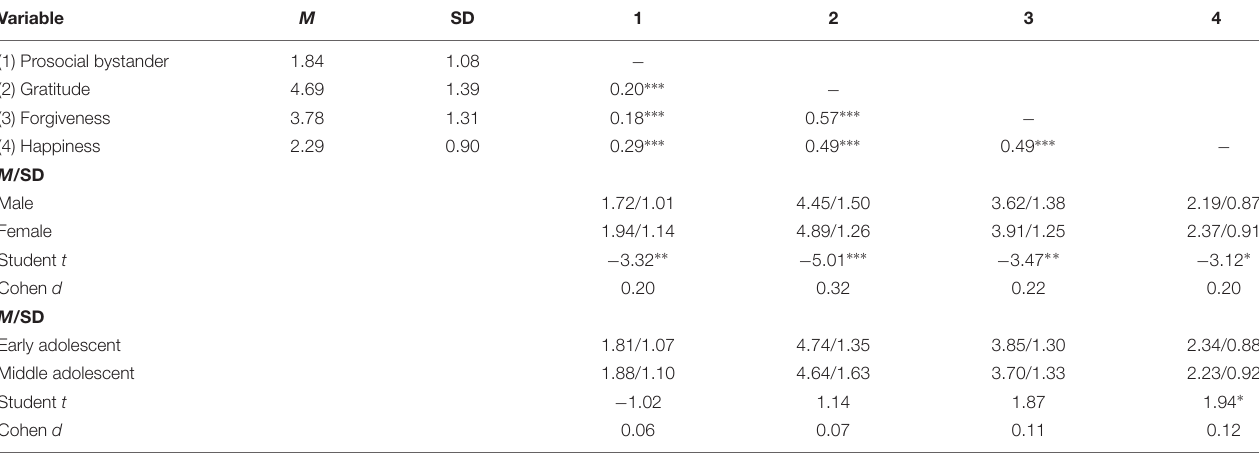
TABLE 1 | Means, standard deviations, correlations, and mean comparisons by gender and stage of adolescence.